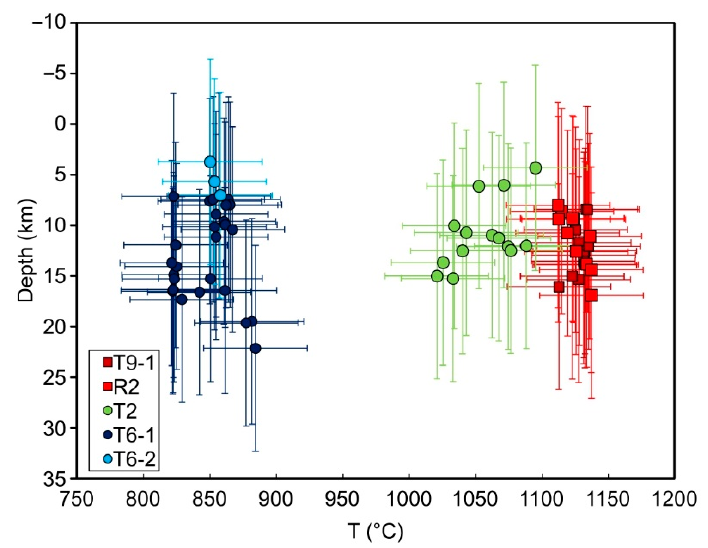
Figure 6. Crystallization temperatures and magma source depths for the MOT and SOT volcanic